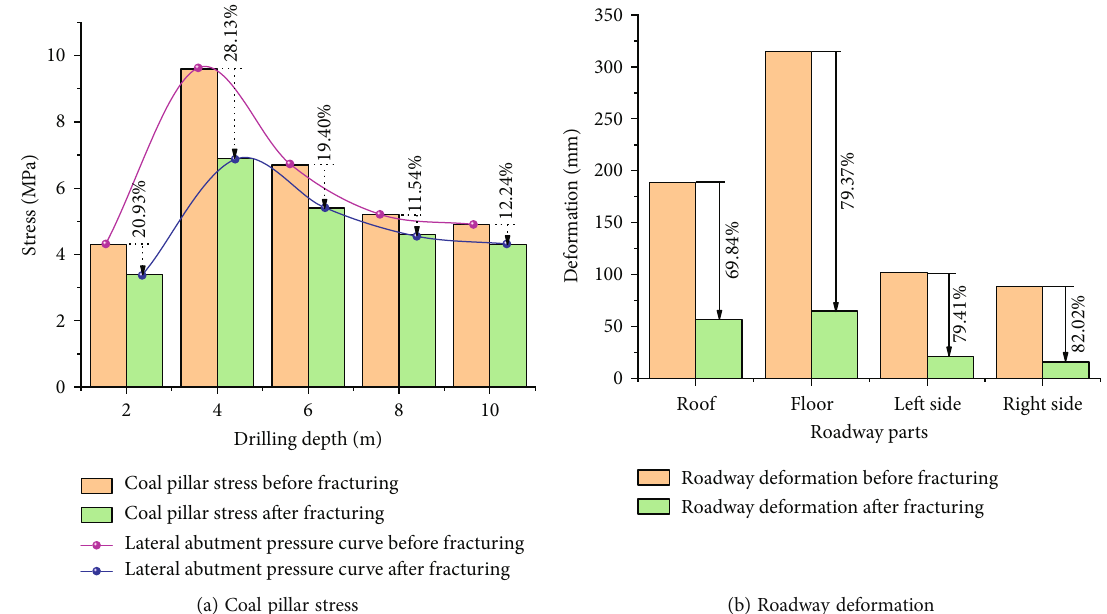
Figure 14: Stress and deformation characteristics of the roadway surrounding rock before and after hydraulic fracturing.